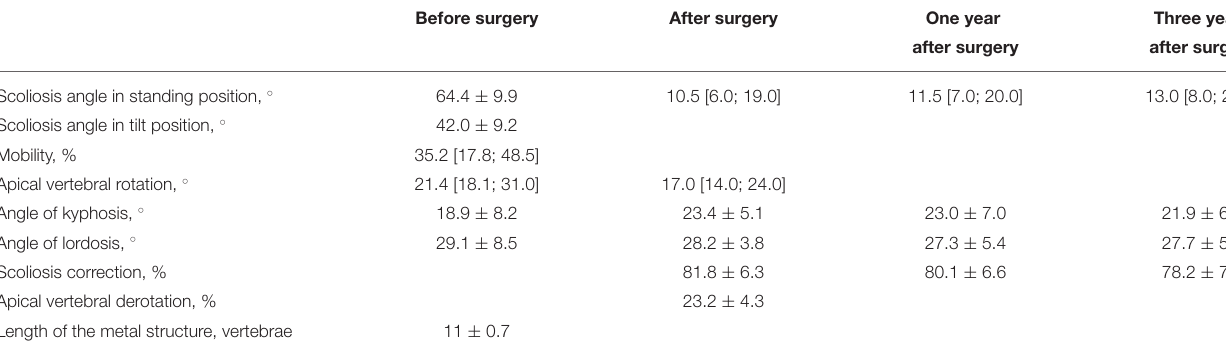
TABLE 2 | The main descriptive statistics for the indicators of the second group, n = 20. Before surgery After surgery One year Three years after surgery after surgery Scoliosis angle in standing position, ◦